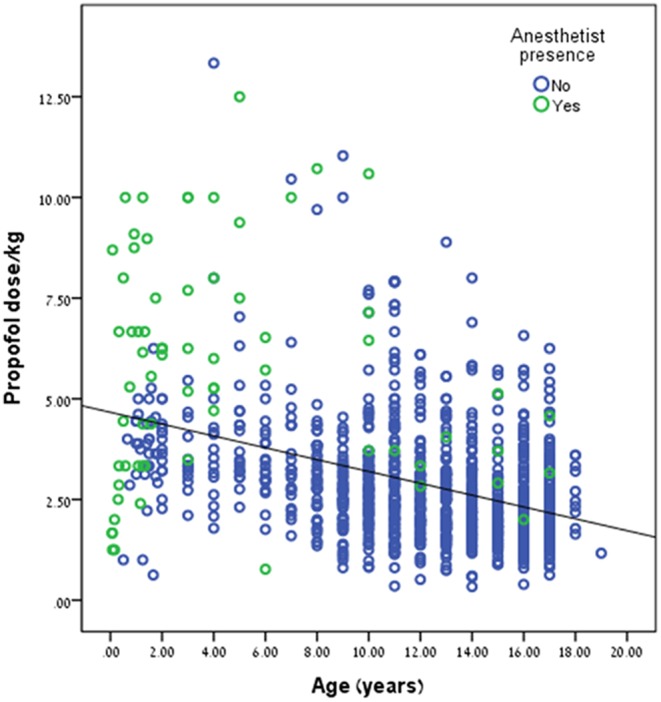
Relation between presence of anesthetist and propofol dose.